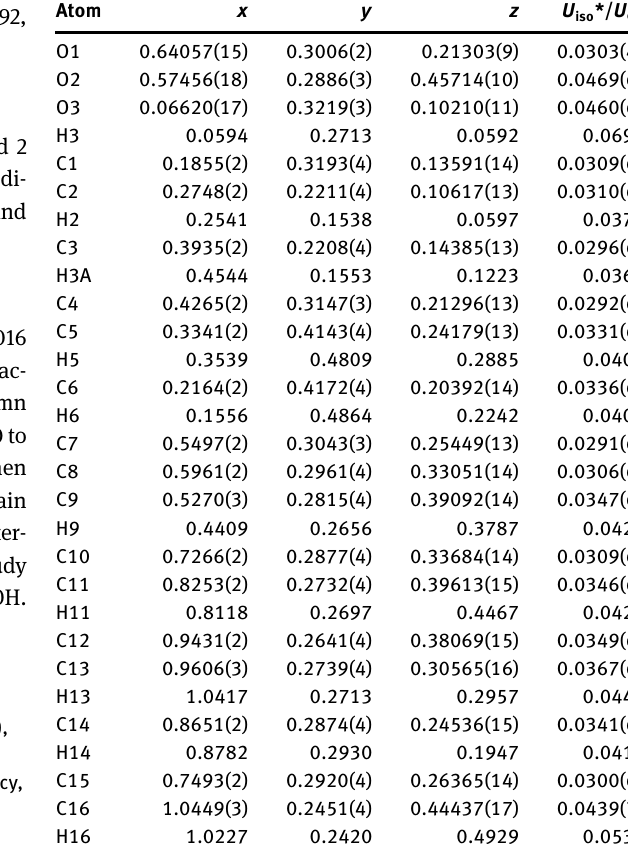
Table 2: Fractional atomic coordinates and isotropic or